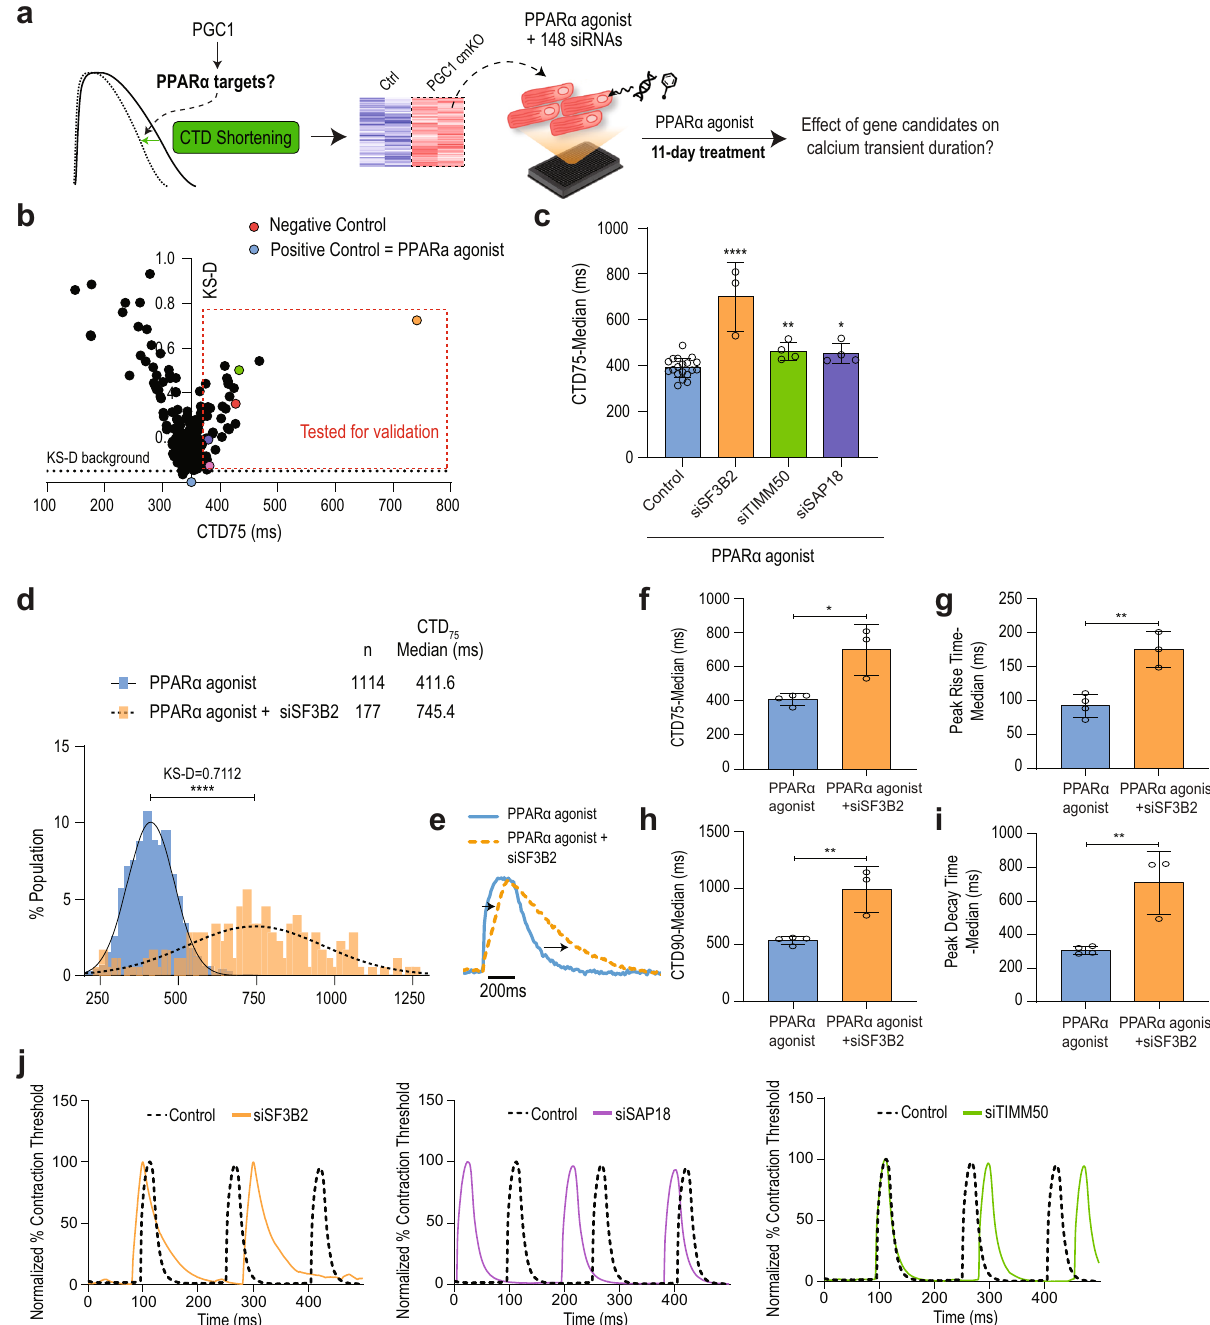
Fig. 7 High-throughput single-cell functional assay shows PGC1/PPAR regulates calcium handling and contraction via SF3B2 in PSC-CMs. a Experimental design for siRNA-based functional assay with 148 genes downregulated in PGC1-de fi cient CMs. b siRNA assay results with Kolmogorov- Smirnov distance (KS-D) and CTD75. Untreated or PPAR α agonist-treated hPSC-CMs were used as negative or positive control, respectively. c Median CTD75 for validated hit siRNAs. Control n = 16 (siSF3B2 (orange) p -value > 0.0001 n = 3, siTIMM50 (green) p -value = 0.005 n = 4, siSAP18 (purple) p -value = 0.0145 n = 4) d Distribution of CTD75 in PPAR α agonist-treated human PSC-CMs with(blue)/without(orange) siRNA targeting SF3B2 . e Representative traces of hPSC-CM calcium transient for PPAR α agonist-treated and PPAR α agonist with siSF3B2. f – i Calcium transient parameters showing functional effects of SF3B2 knockdown. j Traces showing effects of validated hit siRNAs on contractility by normalized percentage of contraction threshold. p -values: *<0.05,**<0.1,***<0.01,****<0.001. ANOVA with post hoc Bonferroni test was used for multiple comparisons. The student ’ s t -test was used. Error bars represent standard